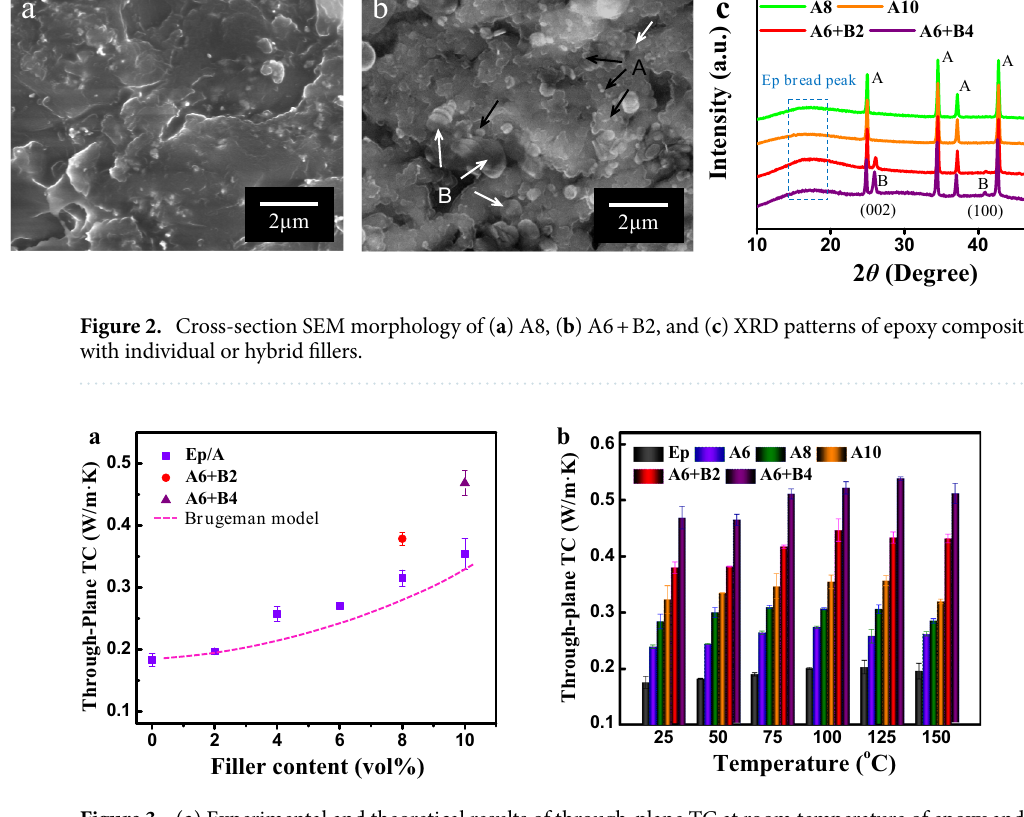
Figure 3. ( a ) Experimental and theoretical results of through-plane TC at room temperature of epoxy and its composites, ( b ) through-plane TC at various temperature of epoxy and its